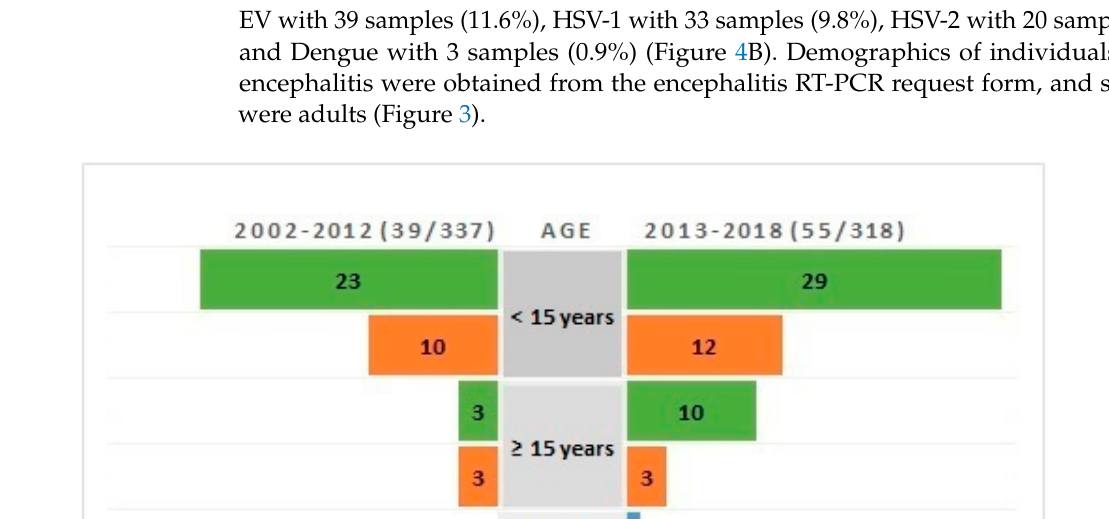
Figure 3. Demographic of individuals with confirmed enterovirus encephalitis in 2002–2012, and in 2013–2018.